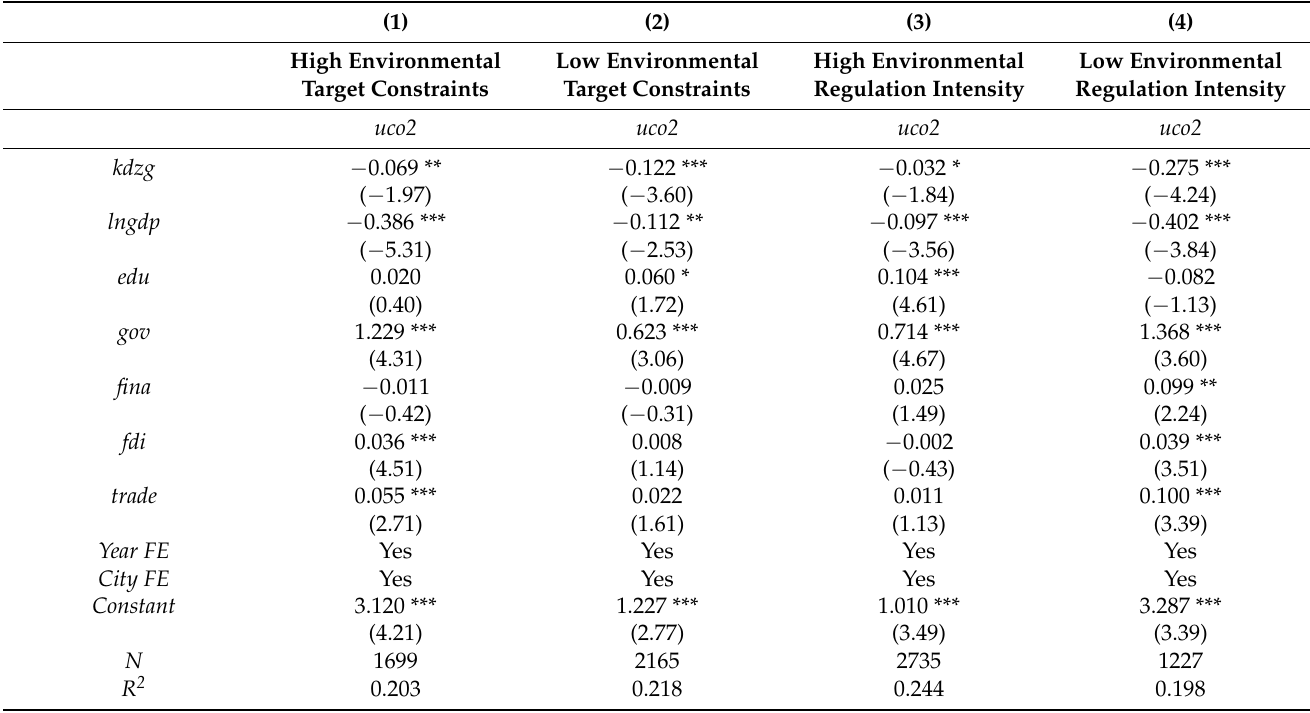
Table 6. Heterogeneity of environmental regulation